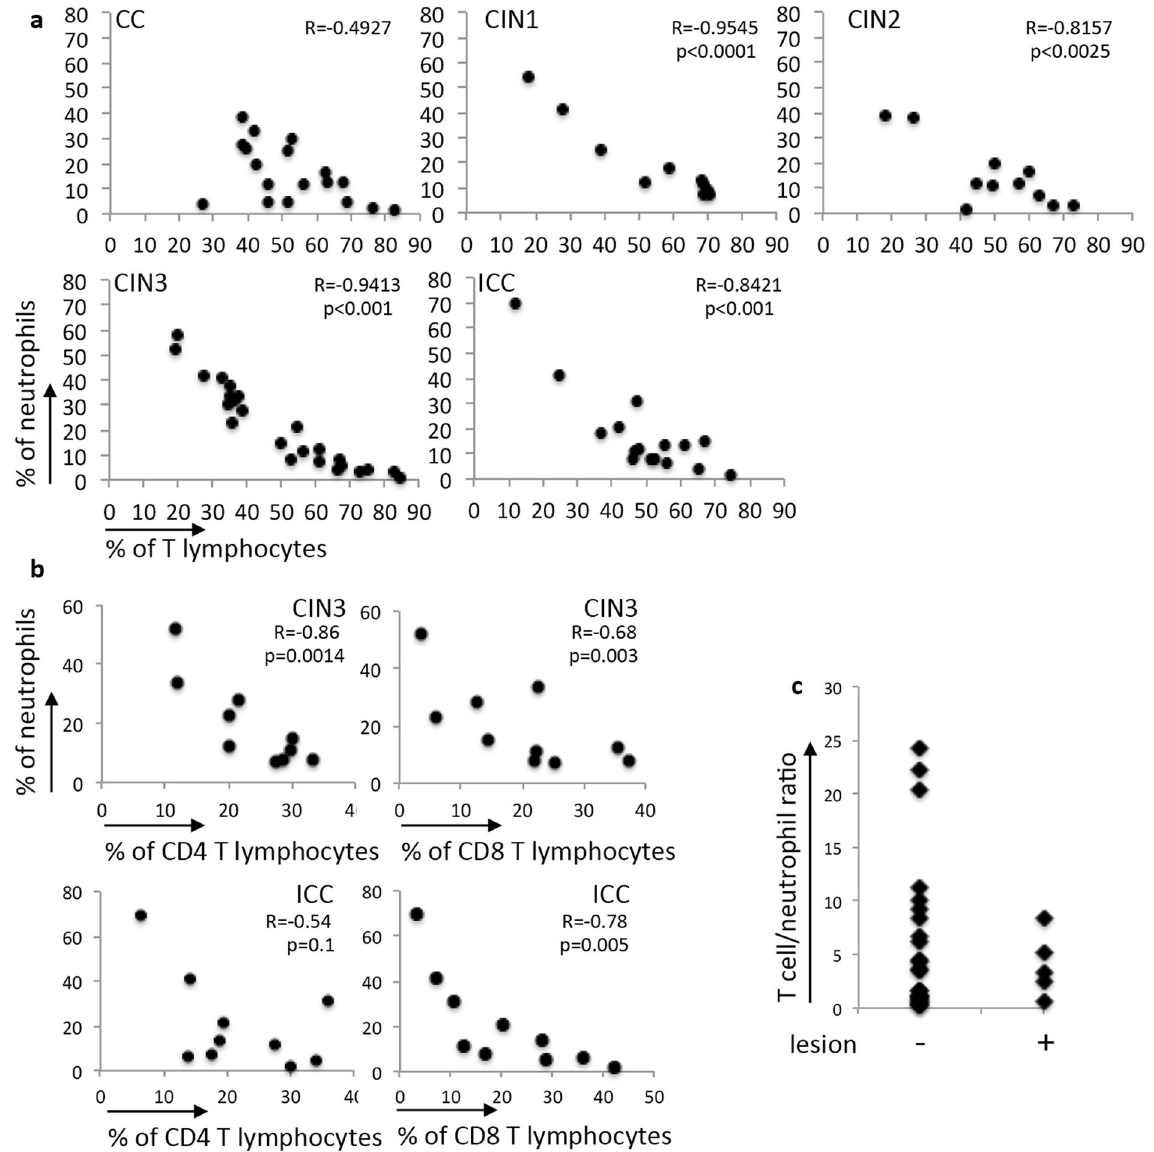
Figure 3. Negative correlation between neutrophils and T cells in CIN and ICC. ( a ) Frequencies of T cells and neutrophils in each cohort group were compared by Pearson correlation. Number of samples per group is described in Fig. 1. ( b ) Comparison between CD4 and CD8 and neutrophil frequencies in CIN3 and ICC samples by Pearson correlation. There were 9 CIN3 biopsies and 11 ICC biopsies in these analyses. The graphs indicate the R values and p values (significance) for each correlation. ( c ) T cell/neutrophil frequency ratio in patients with CIN1, 2 and 3 free of disease ( − ) or with persistent or recurrent disease ( + ) after excision procedure. Follow up period varies between 1 and 3